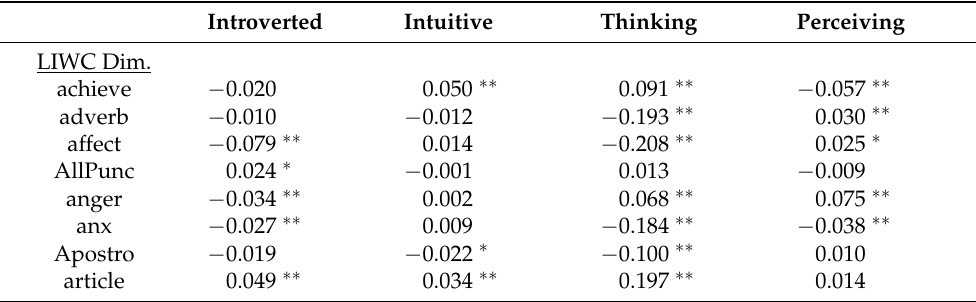
Table 10. Correlation between MBTI types and LIWC features present in the PANDORA dataset. LIWC features that correlate with at least one MBTI type are shown in the table. Introverted Intuitive Thinking Perceiving LIWC Dim. achieve − 0.020 0.050